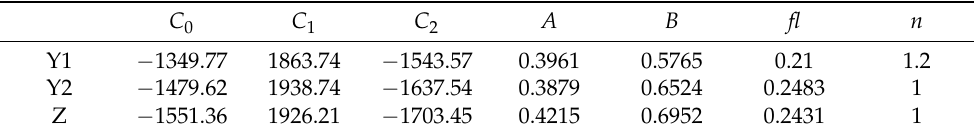
Table 2. Bouc–Wen model parameters of each axis of 3D-EVC